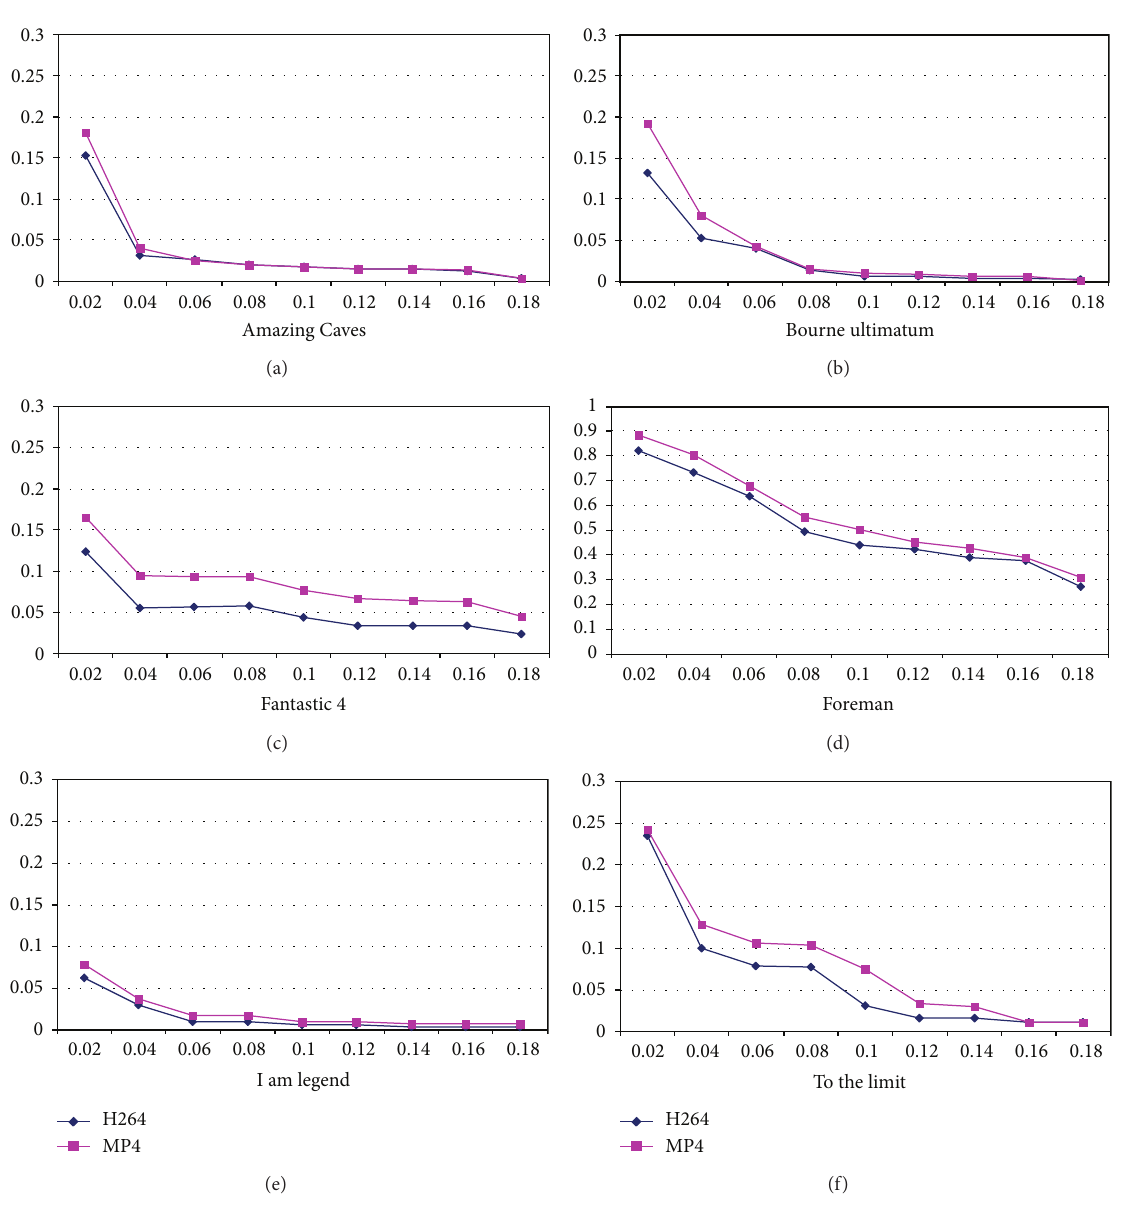
Figure 9: Ratio between decoded layers and sent layers (based on